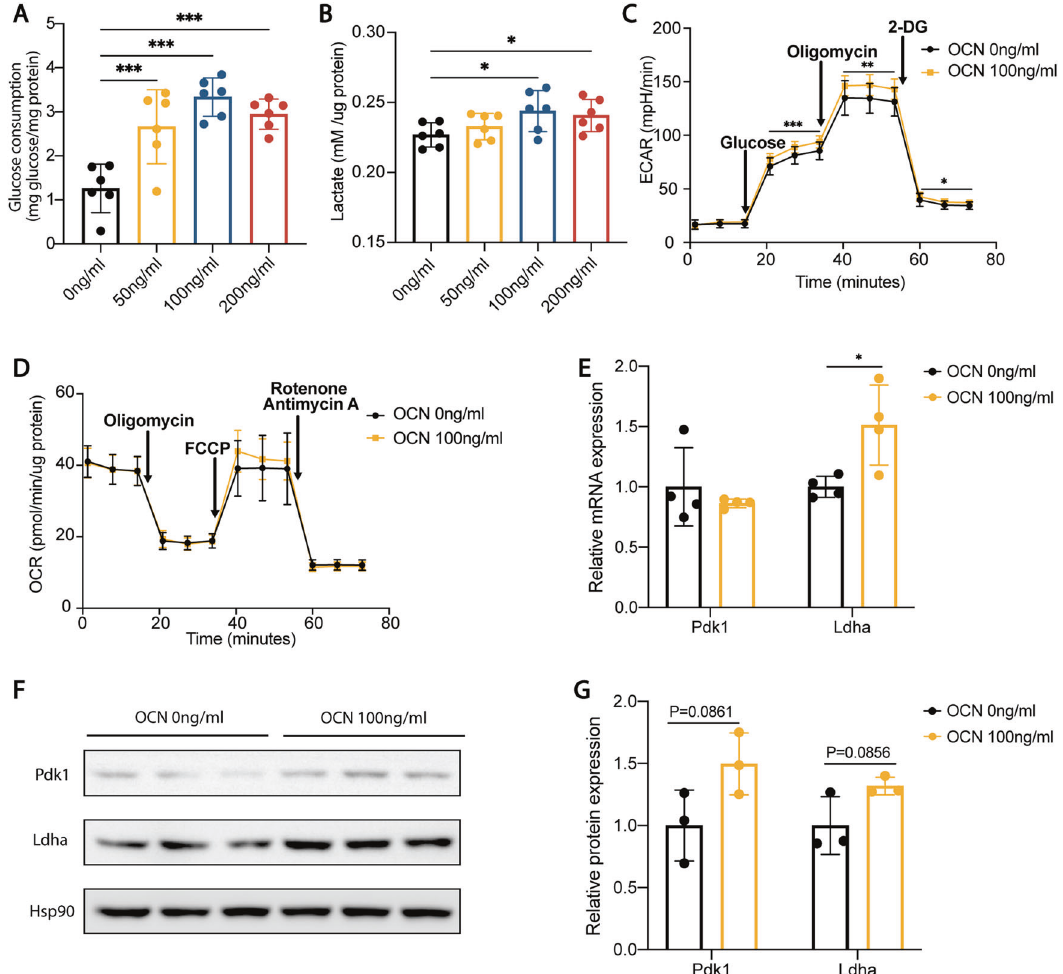
Fig. 6 OCN enhanced glycolysis in microglia. A Glucose consumption (normalized to total protein) of BV2 cells treated with vehicle or different concentrations of OCN. B Lactate production (normalized to total protein) of BV2 cells treated with vehicle or different concentrations of OCN. C , D Oxygen consumption rate (OCR) and extracellular acidi fi cation rate (ECAR) of BV2 cells treated with vehicle or 100 ng/ml of OCN. Results are normalized to total protein. E qPCR analysis of mRNA levels of glycolytic enzymes of BV2 cells treated with vehicle or 100 ng/ml of OCN. F , G Protein levels of glycolytic enzymes of BV2 cells treated with vehicle or 100 ng/ml of OCN. (Data are presented as mean ±